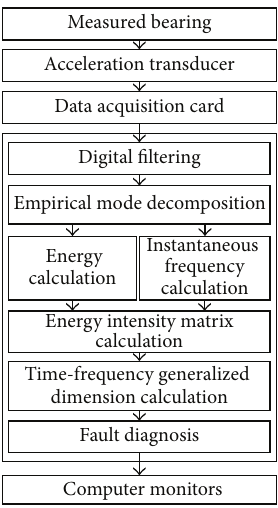
Figure 14: Experimental flow charts.